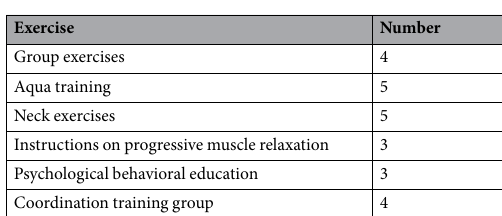
Exercise Number